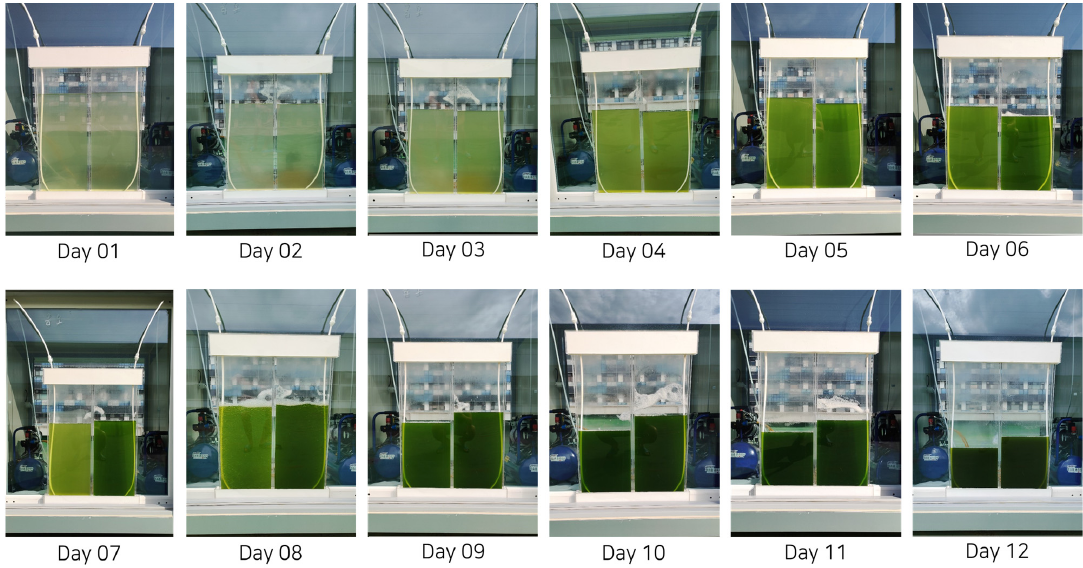
Figure 5. Change of microalgae’s density during mock-up test (Adapted from Ref. [26]).